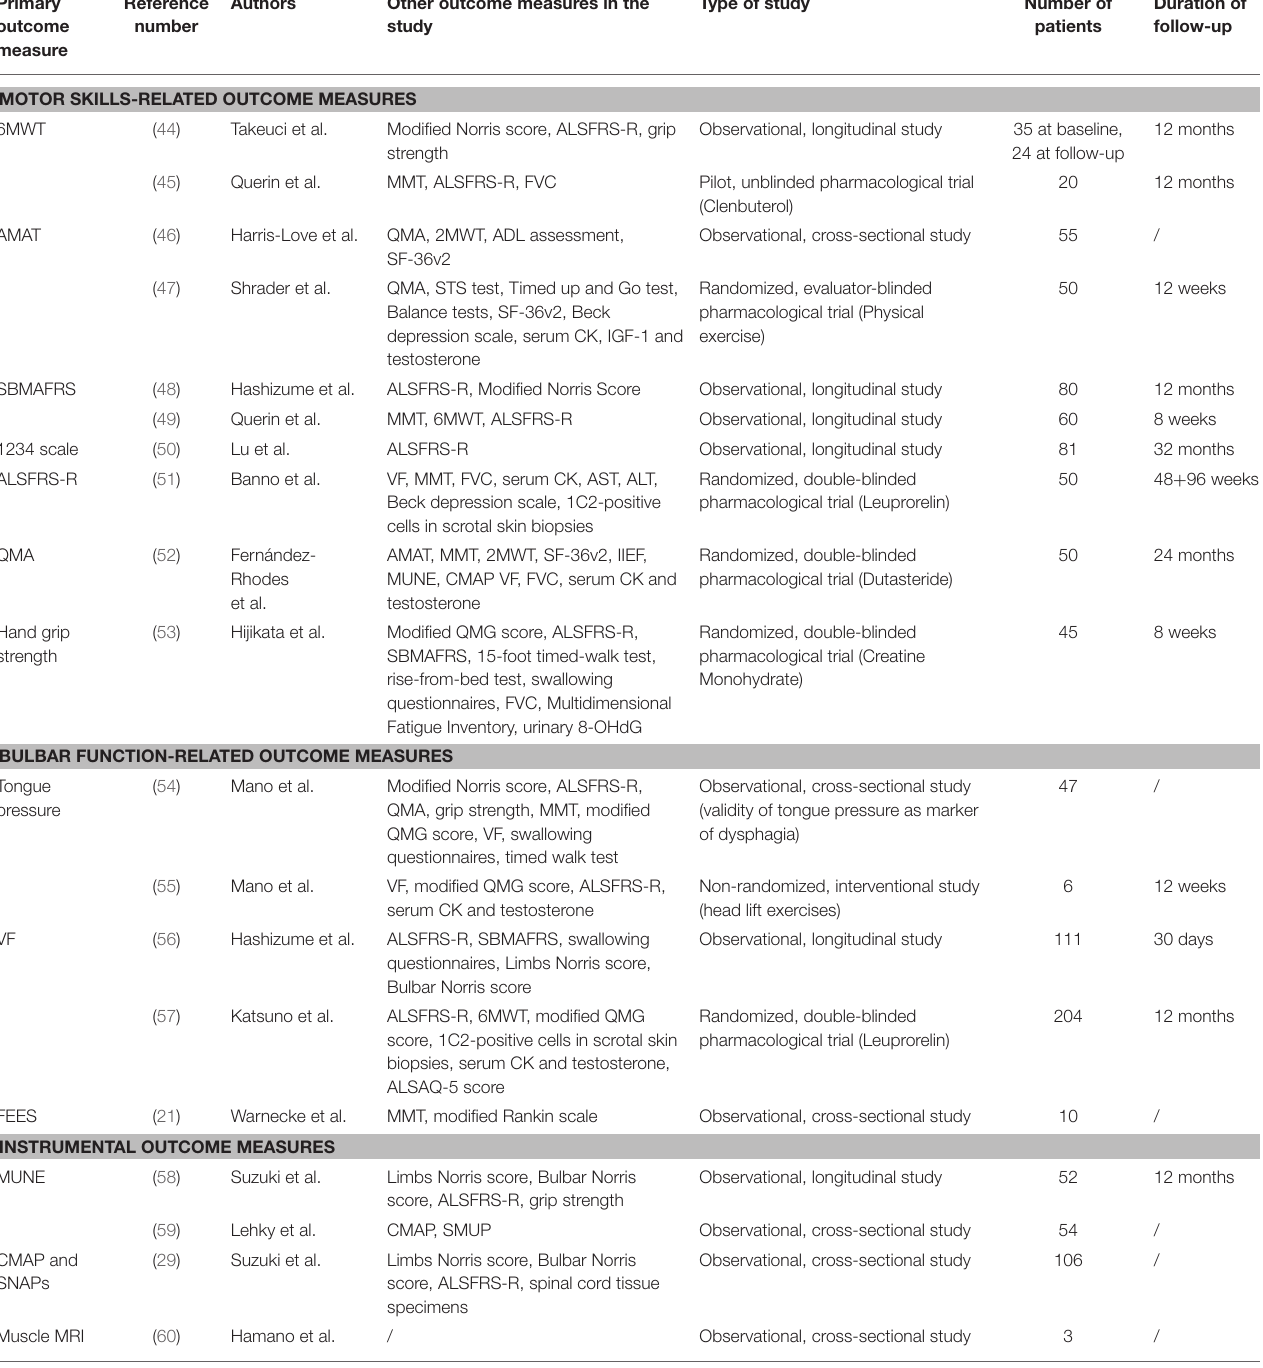
TABLE 1 | Research studies considering motor and bulbar skills-related outcome